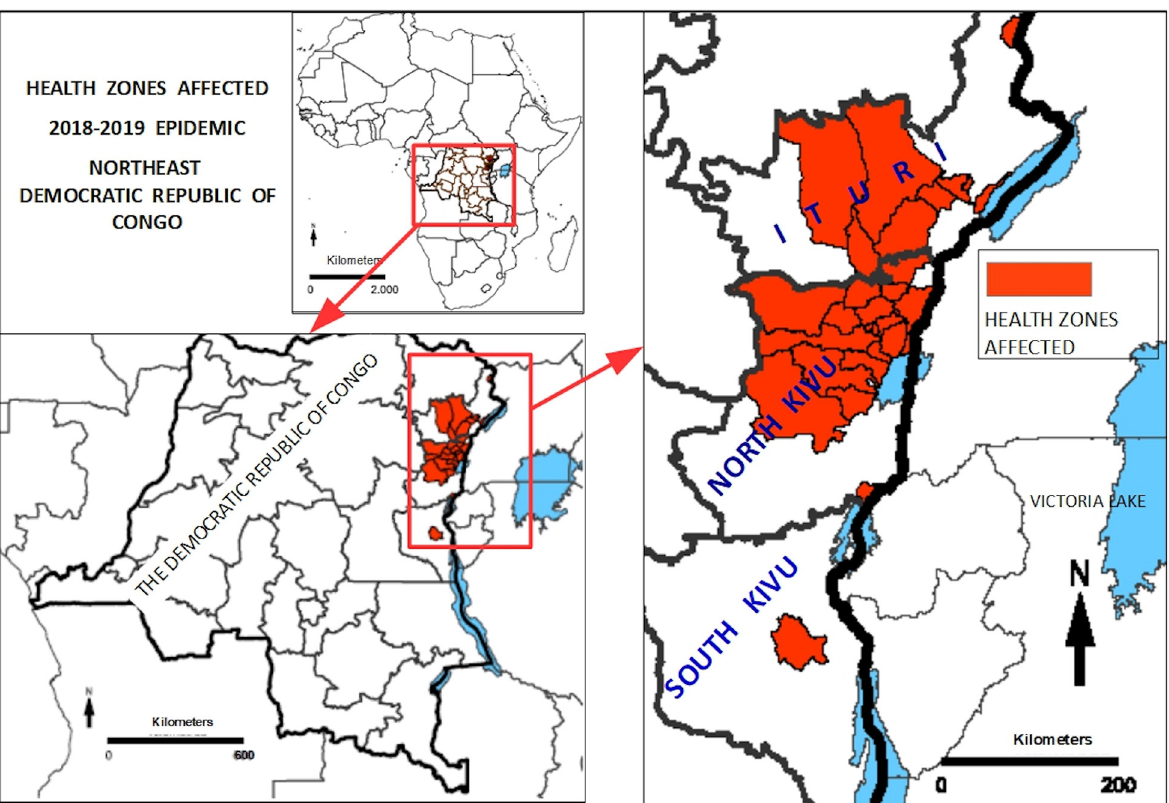
Fig. 10. Affected health zones are given in